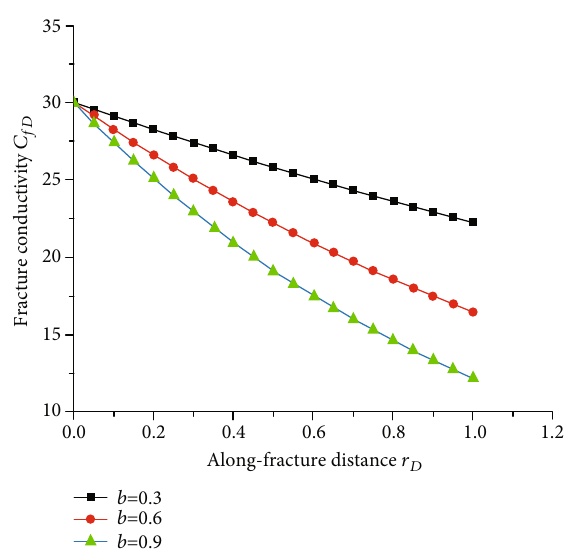
Figure 2: Variation of the fracture conductivity with the along- fracture distance at di ff erent exponent coe ffi cients.